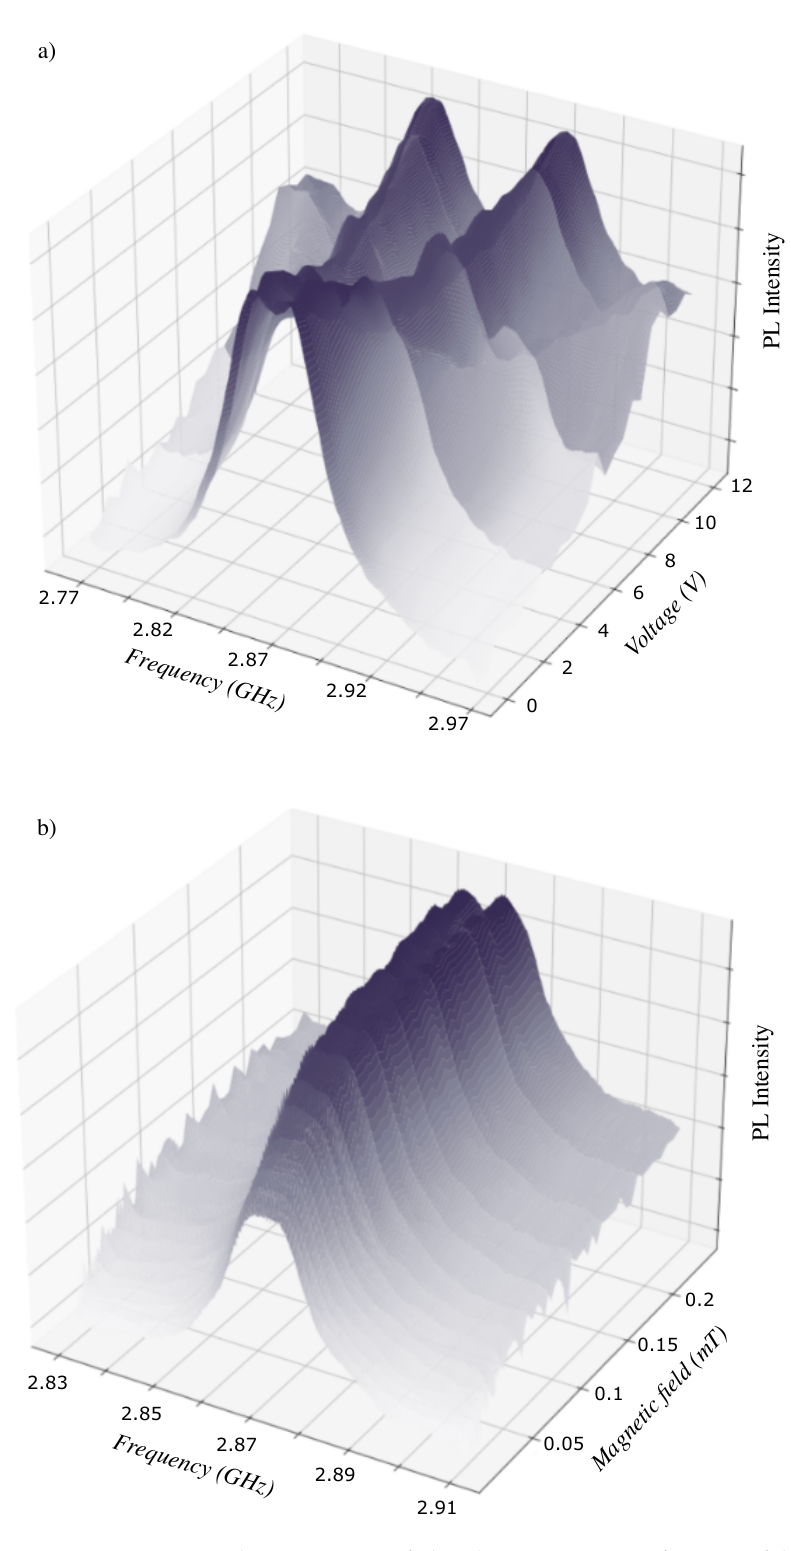
Figure 10. Experimental measurement of photoluminescence as a function of the magnetic field for frequencies in the range of 2.7 to 3 GHz where it is observed how the gap between the resonance holes grows when the magnetic field increases. A 3D view, combining the three dimensions, photo- luminescence, frequency, and magnetic field. ( a ) is obtained by using the described electromagnet, changing the voltage and ( b ) is the result of the characterization moving the permanent magnet away at each